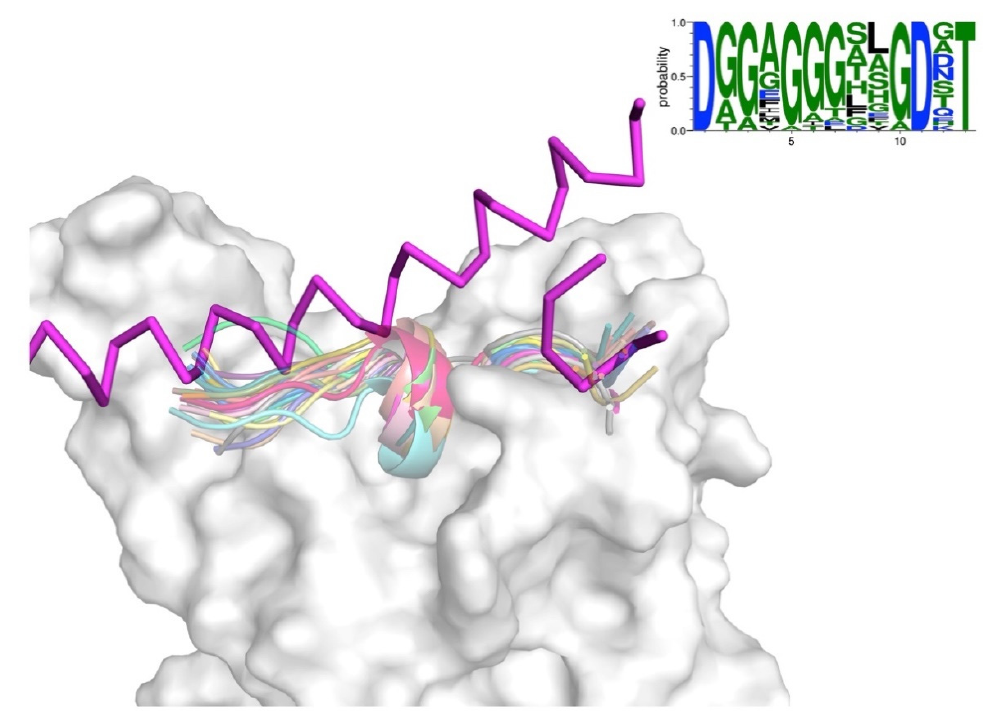
Figure 4. Structural ensemble of peptides targeting a common region of the target surface. RBD of SARS-CoV-2 S protein is shown in white and surface representation while the H1 helix of ACE2 is shown in magenta and ribbon. The different designed peptides are shown in different colours and translucent cartoon representation. A web logo [33] depicting the conservation is shown in the top right side.